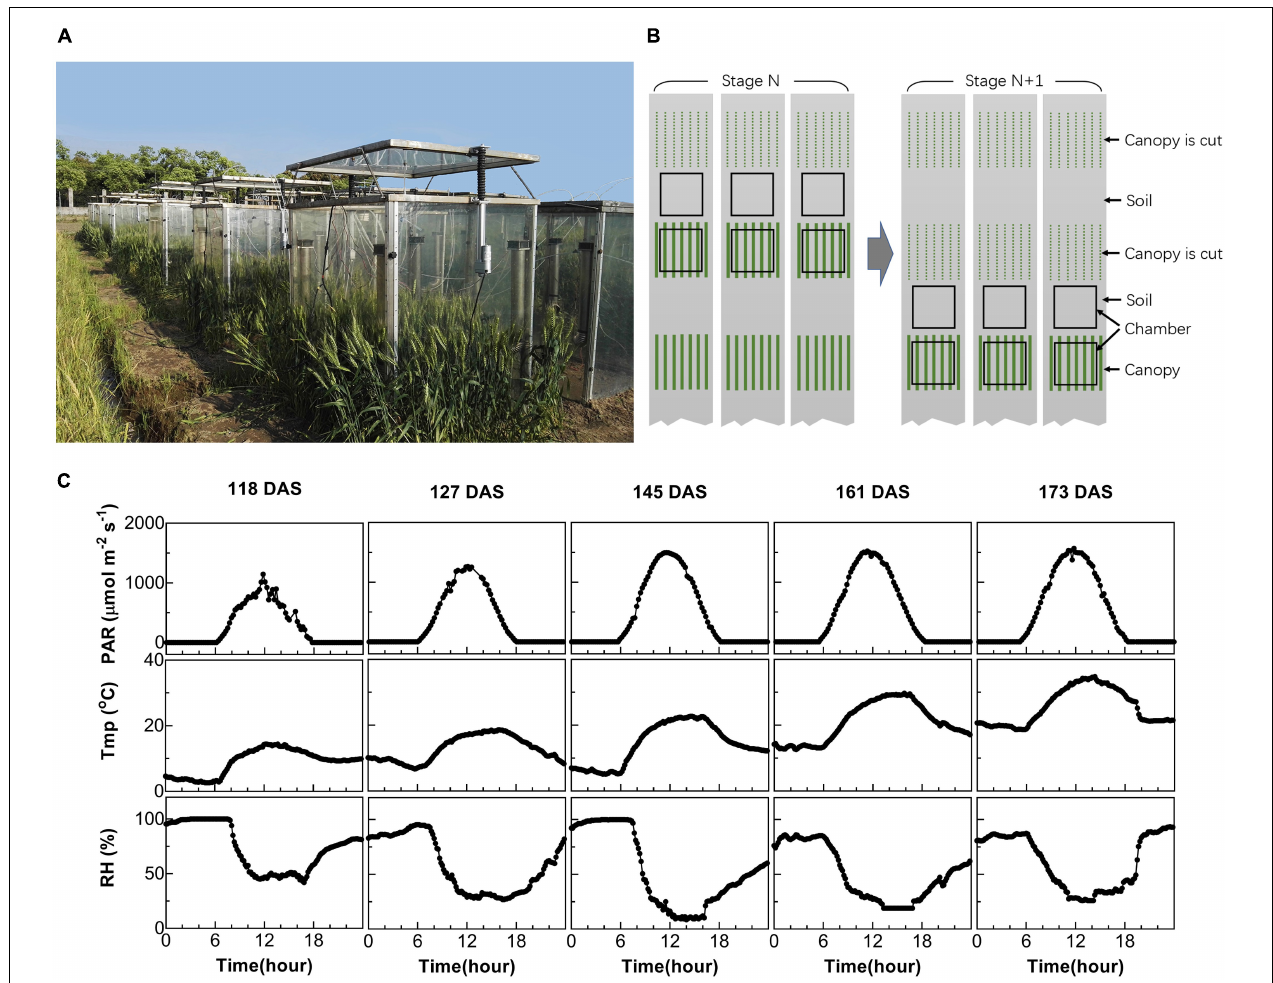
FIGURE 1 | Measurement of canopy photosynthesis on field-grown wheat. (A) Multi-chamber canopy photosynthesis and transpiration system (multi-CAPTS) used for field canopy gas exchange measurement. (B) Diagram showing the logistics during the measurements. At stage N, three canopy chambers were used to measure the whole system’s CO 2 flux, while three other chambers were used to measure the CO 2 flux for soil. These canopy chambers were moved out of the field after the measurements at each stage; the plants used for the gas exchange measurement were harvested for biomass dry weight measurements. The chambers were then moved to new plots for gas exchange measurement at the next (N+1) stage. (C) Diurnal changes of environmental factors, including photosynthetic active radiation (PAR), air temperature (Tmp), and air relative humidity (RH) for 5 days at different stages when canopy photosynthesis were